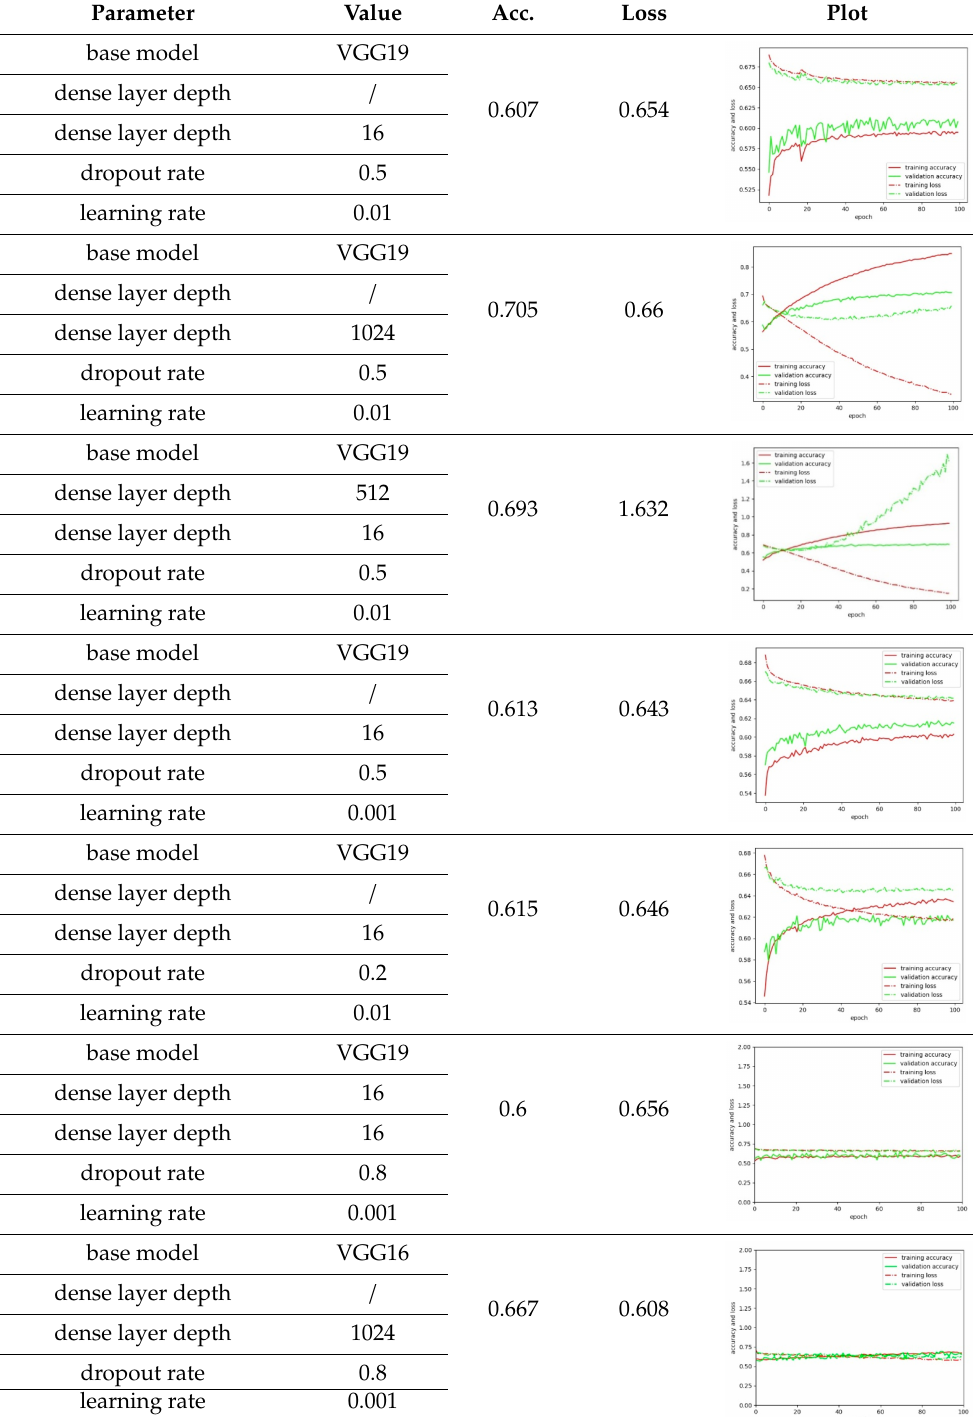
Table A1. Results obtained on validation data for di ff erent fine-tuned CNNs. The one used for further analysis in our study is outlined in green. The legend text corresponds to that of Figure